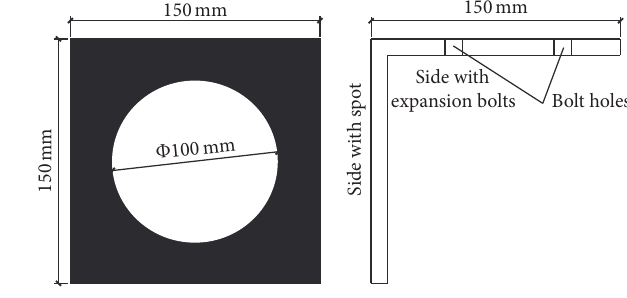
Figure 9: Schematic diagram of circular target.